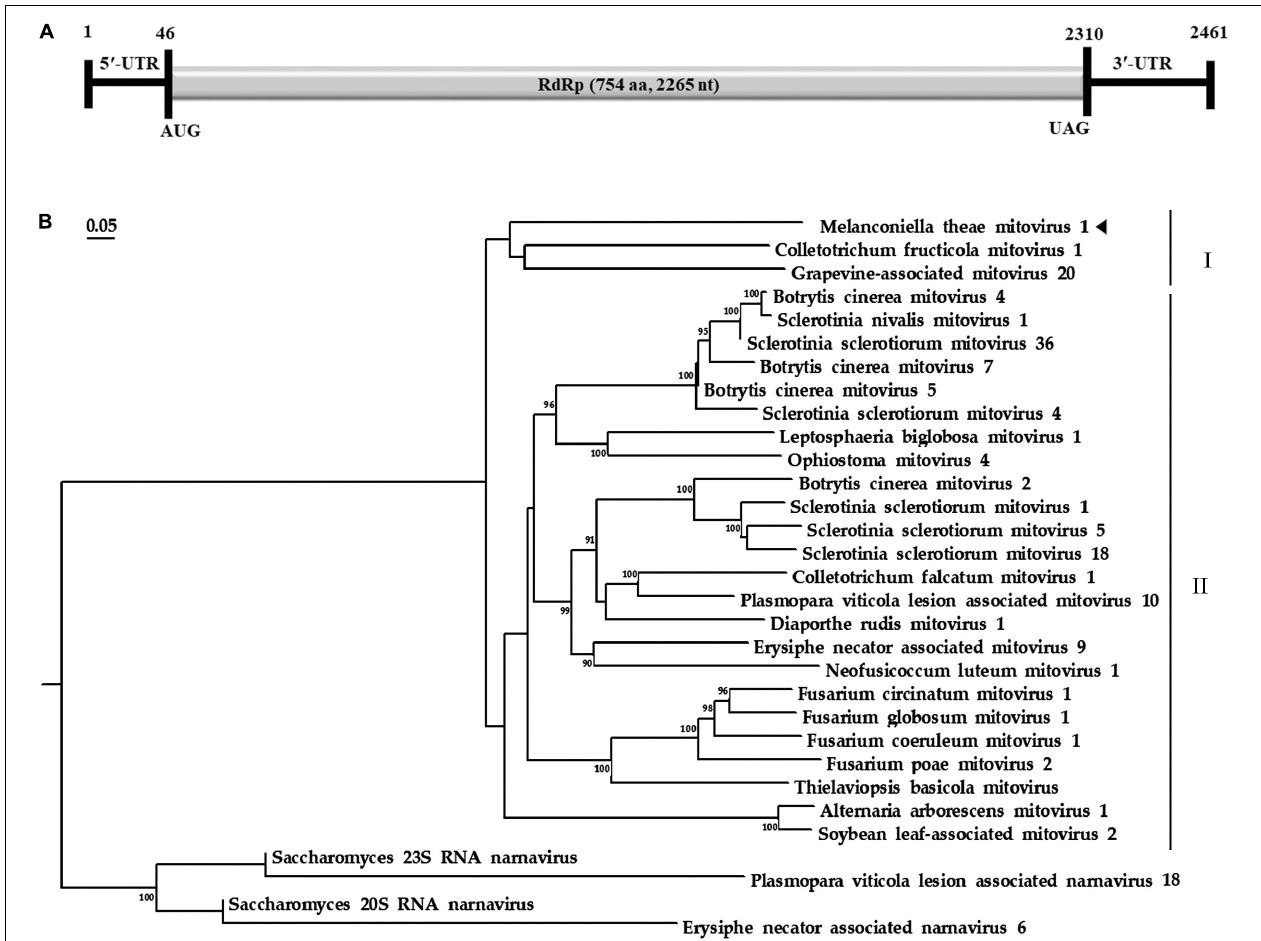
FIGURE 2 | Genomic organization and phylogenetic analysis of MtMV1. (A) Genome organization of MtMV1. The start and end positions are labeled for the genome, untranslated regions (UTR), and the open reading frame (ORF). (B) ML phylogenetic tree was constructed using DNAMAN software based on RdRp sequences of MtMV1 and other members in the family Mitoviridae listed in Table 1 . The bootstrap values were deduced based on 1,000 replicates and indicated beside the branches. The evolutionary distances were computed using the Poisson correction method and the branch lengths correspond to the genetic distance; the scale bar refers to the genetic distance of 0.05. A tringle indicates